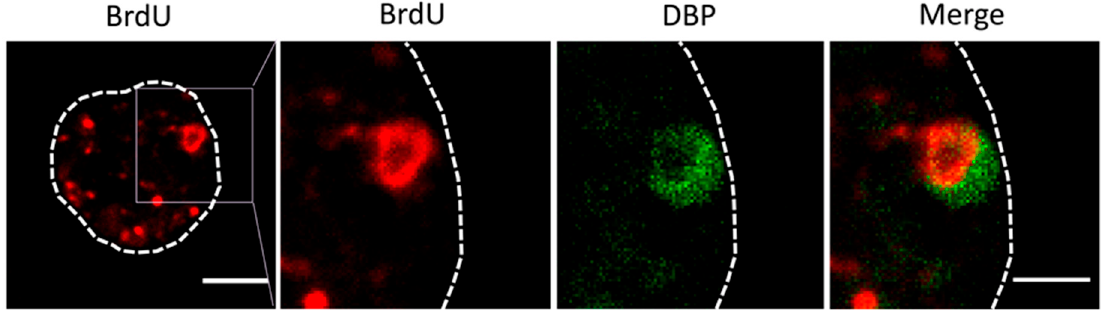
Figure 5. Double labeling for BrdU (red) and DBP (green) in cells infected with Ad5/FC31. The dotted line indicates the cell contour, and the square points out the magnified area in the following panels. Bar: 5 µm (left panel) and 2.5 µm (right panel).